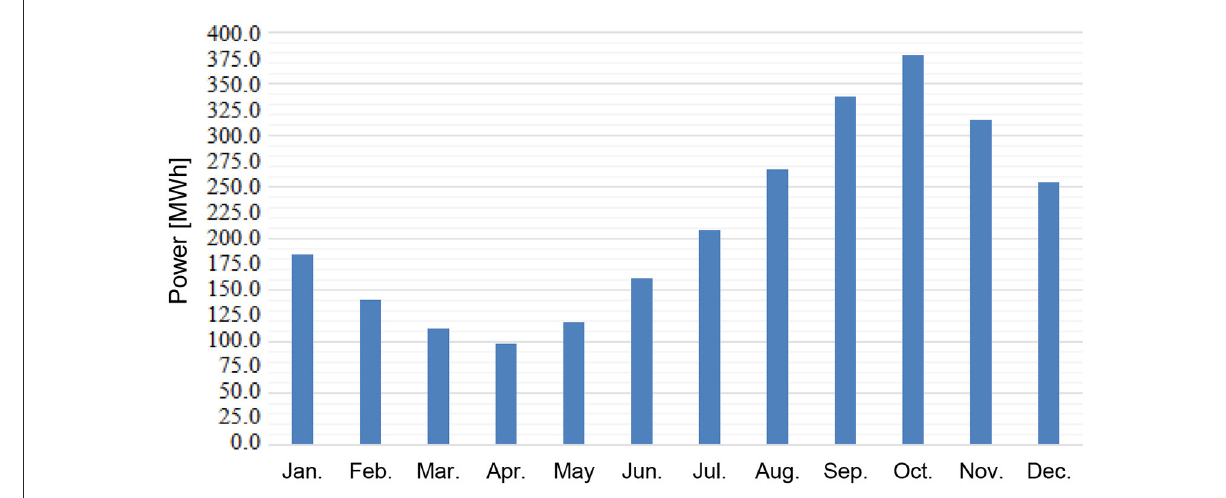
FIGURE2 Monthly mean wind turbine power.